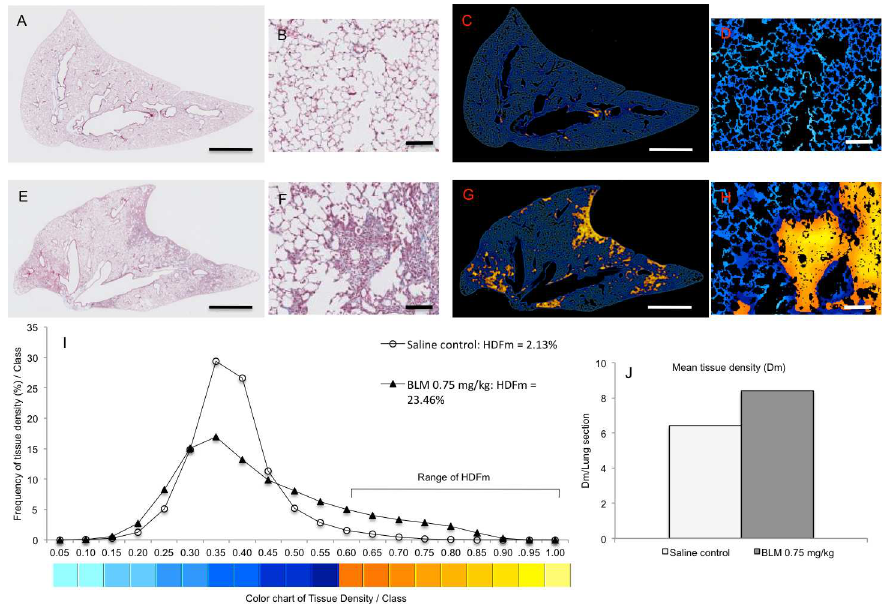
Fig 1. Representative images of original and 2D-reconstructed lung sections for the quantification and the mapping of pulmonary tissue density by meansof digital automatic analysis. Massontrichrome- stainedimages(A, E) and their respective 2D-reconstructed images(C, G) correspond to a lungsection from salinecontrol(A, C) and BLM-treated (0.75mg/kg) lungs(E, G). PanelsB, D, F, H show detailsfrom their originalstained(B, F) and 2D-reconstructed (D, H) imagesat highermagnification. Lungtissuedensity was determined from thousandsof micro-tiles crisscrossing entirelungsections. For mappingthousands tissue densityvaluesthroughout lungsection densityvalueswere gradedin 20 classesof increasingvalues(I) and pseudocolours were assignedfrom blue(lowdensity values)to yellow(highdensityvalues)accordingto their classification. Note that highdensityvalues(yellow)wererestricted in alveolarparenchyma of BLM-treated lung (G, H) and locatedin fibrotic lesionsevidencedin the respectiveoriginalstainedimage(E, F). The frequency of tissuedensity(I) was determined from the classification of the wholeunitarydensityvaluesobtainedin each lungsection(A, E). HDFm indexcorresponds to the sum of the frequencies of the highesttissuedensity (classes12 to 20) expressedin fibrotic foci. The meantissue density(Dm) (J) was evaluatedfor eachlung sectionfrom thousandsof micro-tiles. Scalebars: 1 mm (A, C, E, G), 100 μ m(B, D, F,